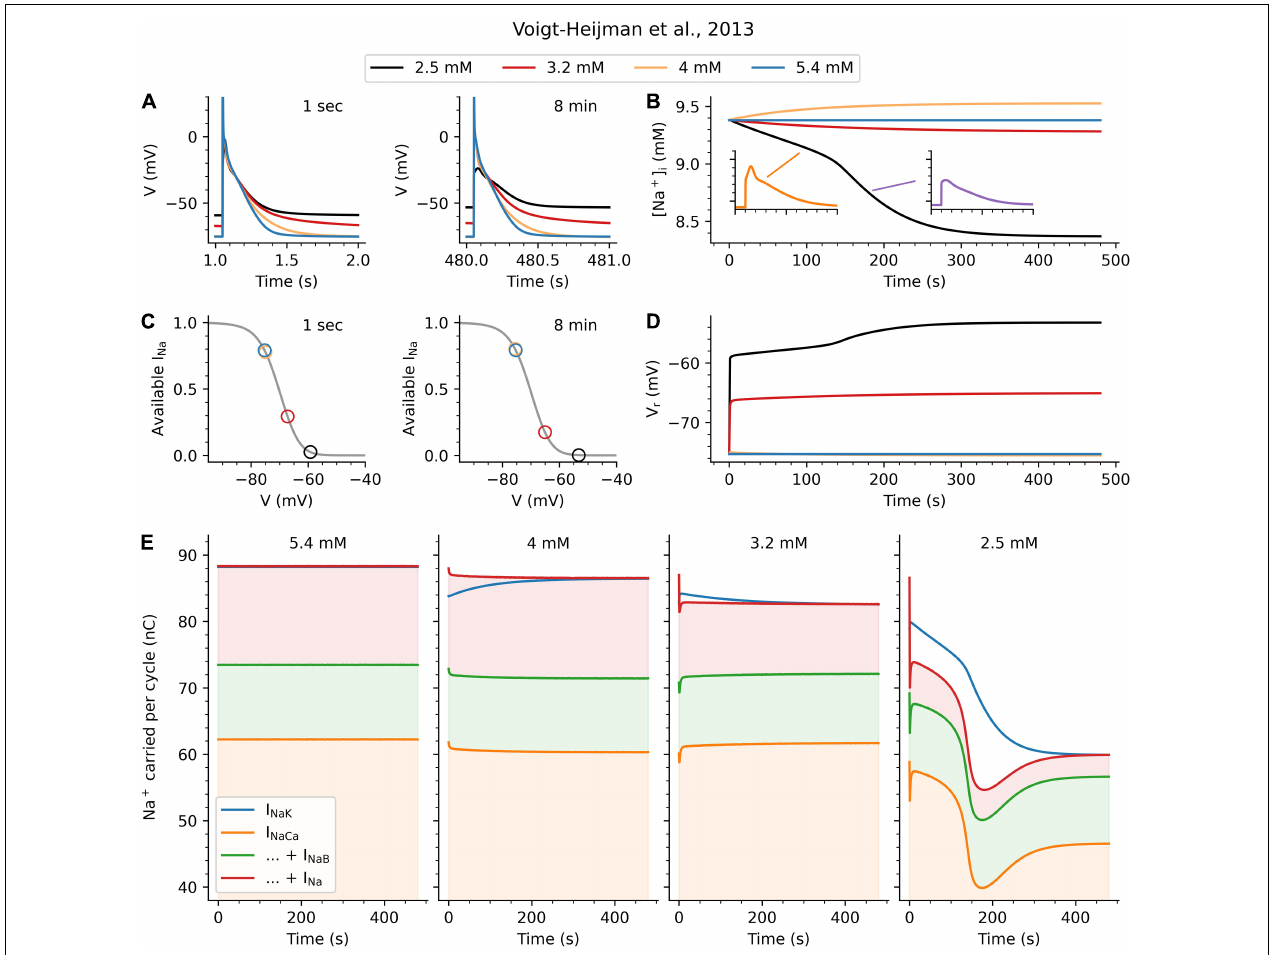
FIGURE 4 | Mechanism underlying longer-term effects of [K + ] o on V r and AP. (A) shows the AP either 1 s (left) or 8 min (right) after a change in [K + ] o from its baseline value of 5.4 mM. The same pattern of effects as in Figure 3 is observed here at 8 min, indicating that the system has stabilized. (B) shows how the [K + ] o changes can cause either a [Na + ] i increase (4 mM) or decrease (3.2 and 2.5 mM) over time. While the changes in [Na + ] i start gradually in all cases, the 2.5 mM hypokalemic condition reveals a secondary effect occurring after around 140 beats. During this rapid transition phase, [Na + ] i steeply declines and the AP waveform undergoes a qualitative change, from a triangular waveform to something resembling a subthreshold response. (C) is based on steady-state inactivation characteristics (gray lines) for I Na . It shows the amount of recovered (available) I Na at V r after 1 s or after 8 min (colored circles) for all [K + ] o conditions (note that the circles for 5.4 mM and 4 mM overlap). (D) shows how the changes to V r develop over time, again showing a dramatic increase at around 140 s for 2.5 mM. (E) shows the charge carried into and out of the cell by Na + ions during each pacing cycle (AP and diastolic interval). The blue line in each graph indicates I NaK , the only outward Na + flux. The orange, green, and red shaded areas shows the influx due to I NaCa , I NaB , and I Na , respectively. The left-most graph illustrates the stable 5.4 mM situation, in which the system is in balance and the sum of inward fluxes equals the outward flux through I NaK . The second panel (4 mM) shows an instantaneous reduction in inward flux (through reduced I NaCa ), and a greater reduction in outward flux (through reduced I NaK ). Over time, this causes the [Na + ] i changes seen in (B) until the system restabilizes. The dominant instantaneous effect in the third graph (3.2 mM) is a decrease in Na + influx through I Na . Again the Na + /K + pump adjusts to compensate and rebalance the system, but now at a reduced [Na + ] i and somewhat depolarized V r . Finally, in the (2.5) case the gradual depolarization of V r grows until no I Na is available for an I Na -driven regenerative AP. These mechanisms are described in further detail in the text and in Figure 6 .